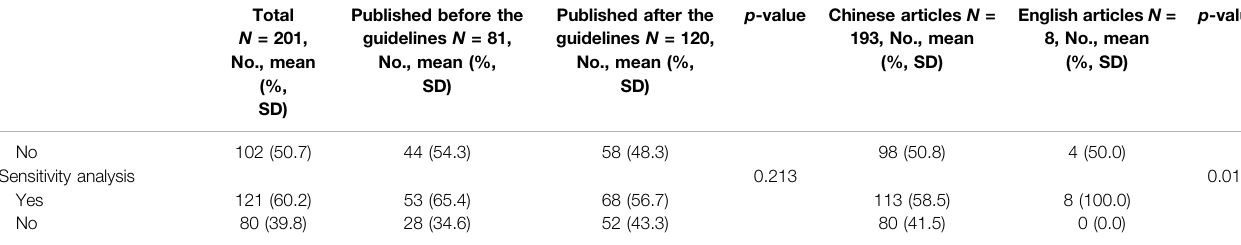
TABLE 1 | ( Continued ) Comparison of characteristics of the included studies before and after the publication of the China PE guideline.